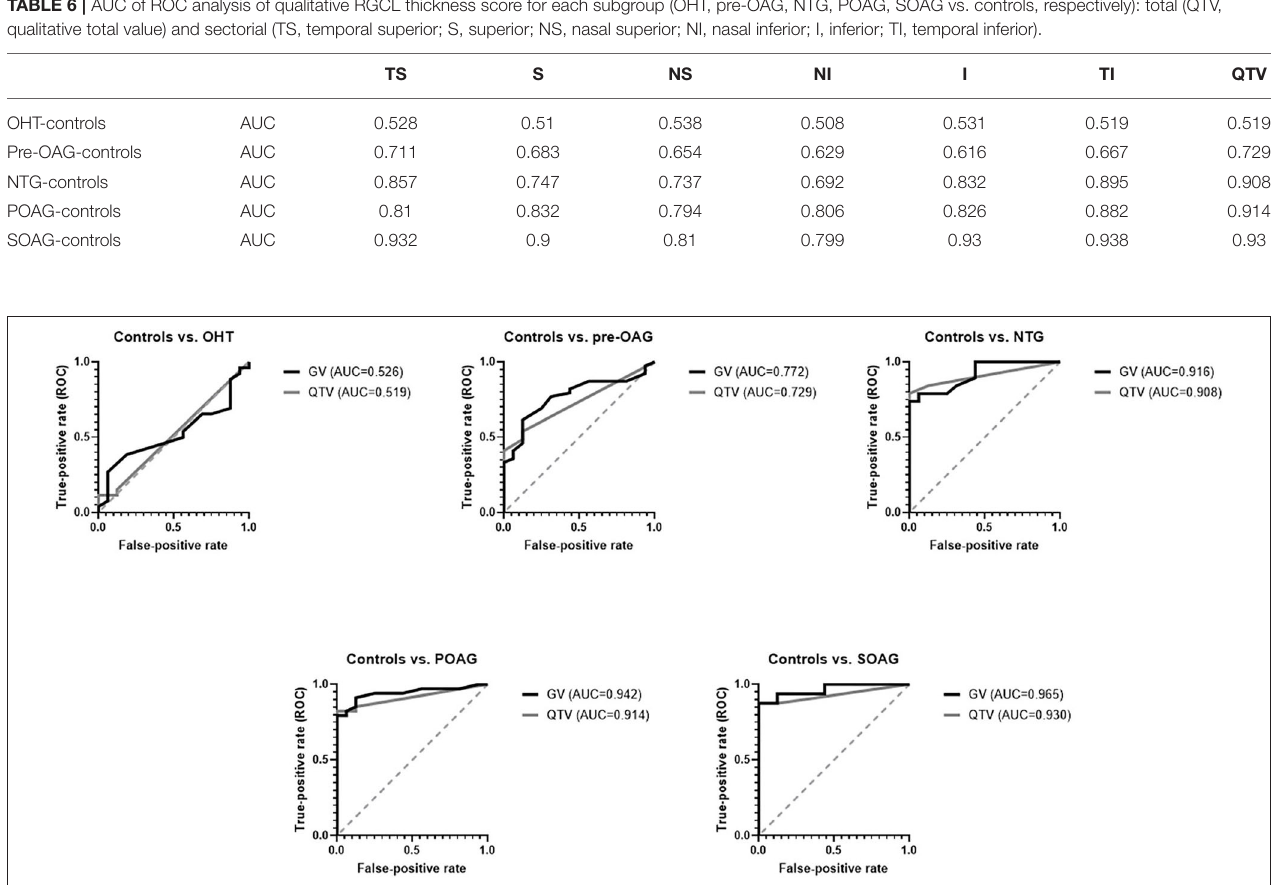
FIGURE 2 | ROC curves for GV and QTV for each subgroup (controls, OHT, Pre-OAG, NTG, POAG, SOAG): GV and QTV yielded similar AUCs.